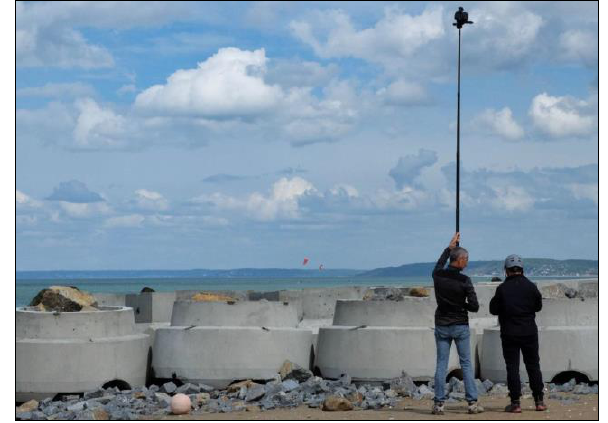
Figure 3 . Pole data acquisition